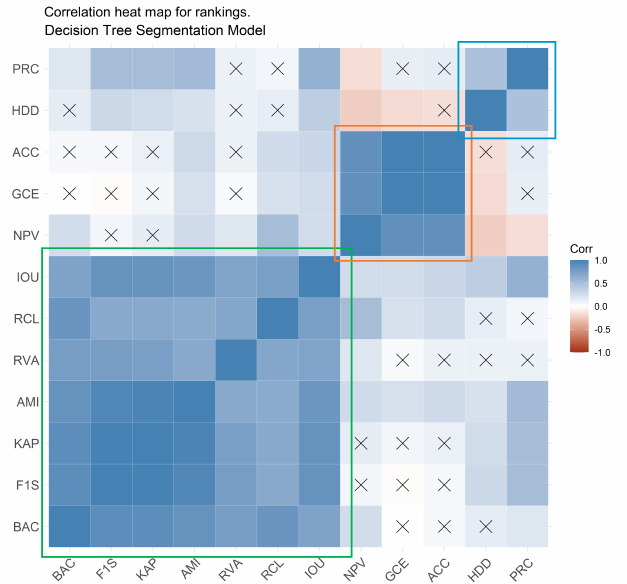
Figure 3. Spearman’s correlation heat map showing the three groups of highly correlated